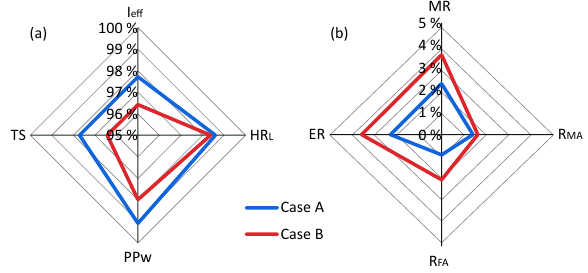
Figure 7. Performance indicators quantifying the landslide early warning performance of Case A (in blue) and Case B (in red) in terms of success (a) and error (b) .